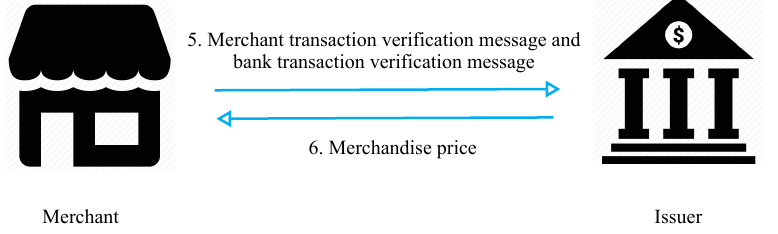
Figure 8. Process of merchant payment request.